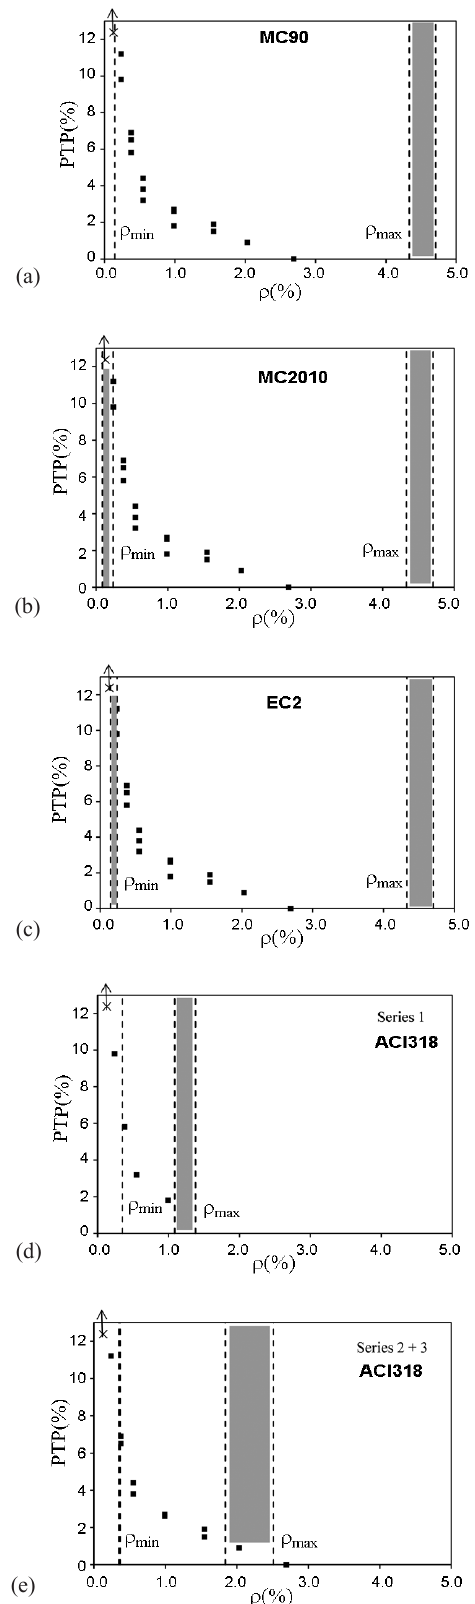
Fig. 10. Graphs r –PTP: (a) MC90 (Fib 1990); (b) MC2010 (Fib 2010); (c) NP EN1992-1-1 (2010); (d, e) ACI 318-11